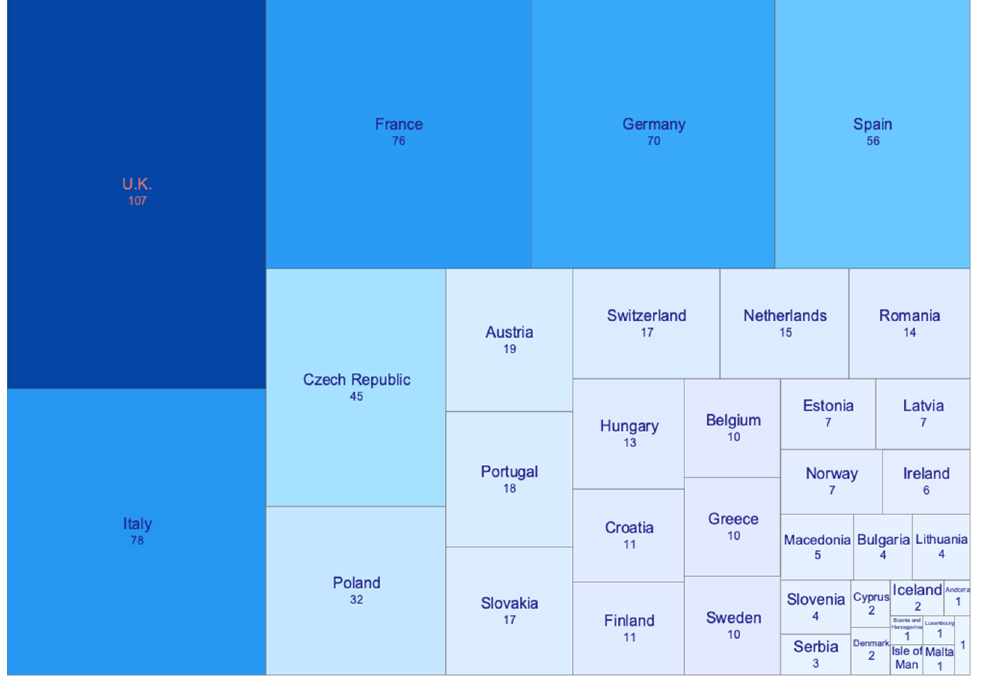
Figure 1. Number of herbaria reported for each European country [27].